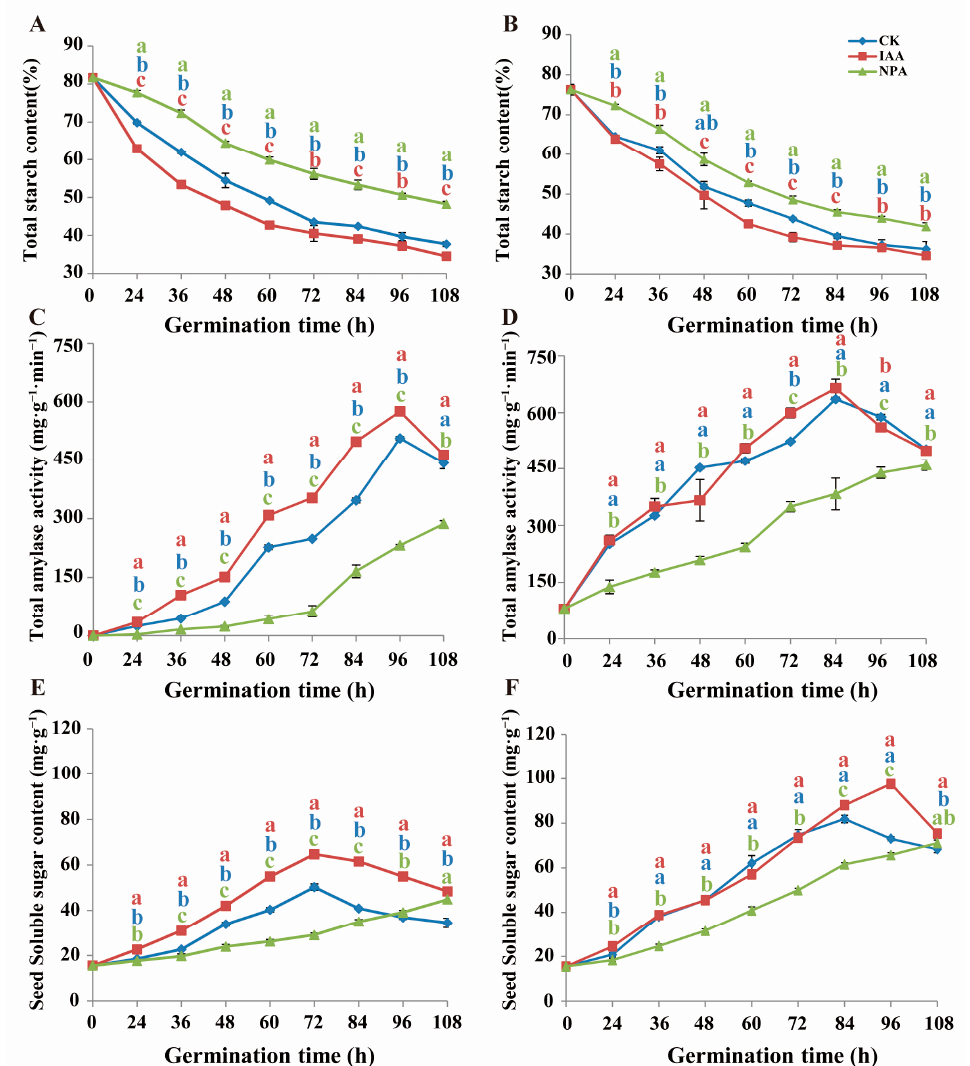
Figure 5. Effects of IAA and NPA treatment on starch content, total amylase activity, and seed soluble sugar of different sorghum inbred lines during germination. ( A ) Total starch content changes from 0 h to 108 h after germination in MS24B; ( B ) Total starch content changes from 0 h to 108 h after germination in Z210; ( C ) Total amylase activity changes from 0 h to 108 h after germination in MS24B; ( D ) Total amylase activity changes from 0 h to 108 h after germination in Z210; ( E ) Soluble